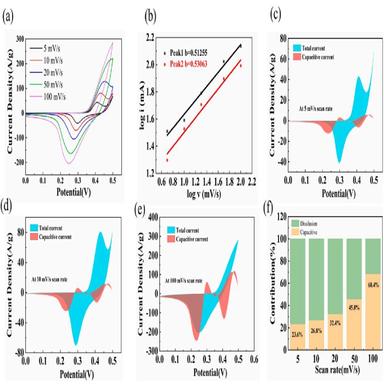
(a) CV curves of the CNFs/CoNiFe(SDS)–LDH (5–100 mV s − 1 ); (b) The linear fitting curves of log (i)-log (v); CV curves with the separation between the total current (blue) and the capacitive (red) current at a scan rate of (c) 5 mV s − 1 , (d) 10 mV s − 1 and (e) 100 mV s − 1 ; (f) Normalized contribution ratios of the capacitive current (yellow) to diffusion-controlled current (green) as a function of scan rate. (For interpretation of the references to colour in this figure legend, the reader is referred